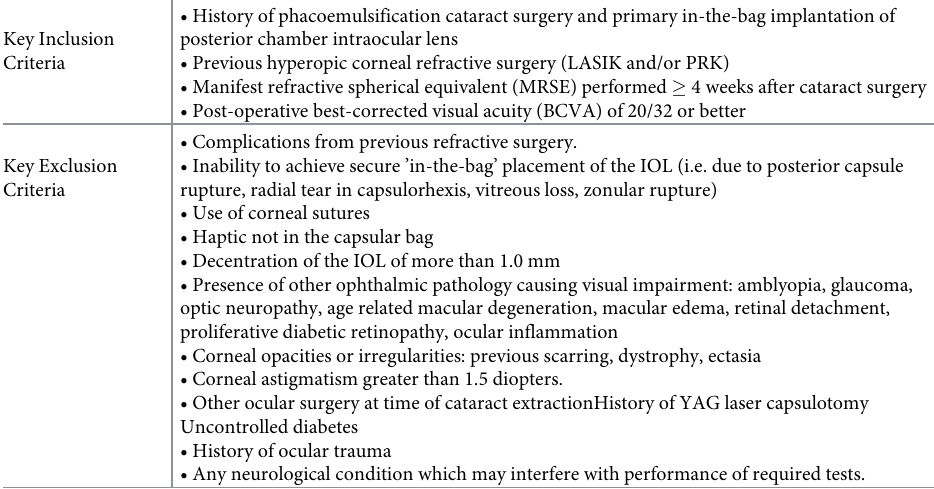
Table 1. Inclusion and exclusion